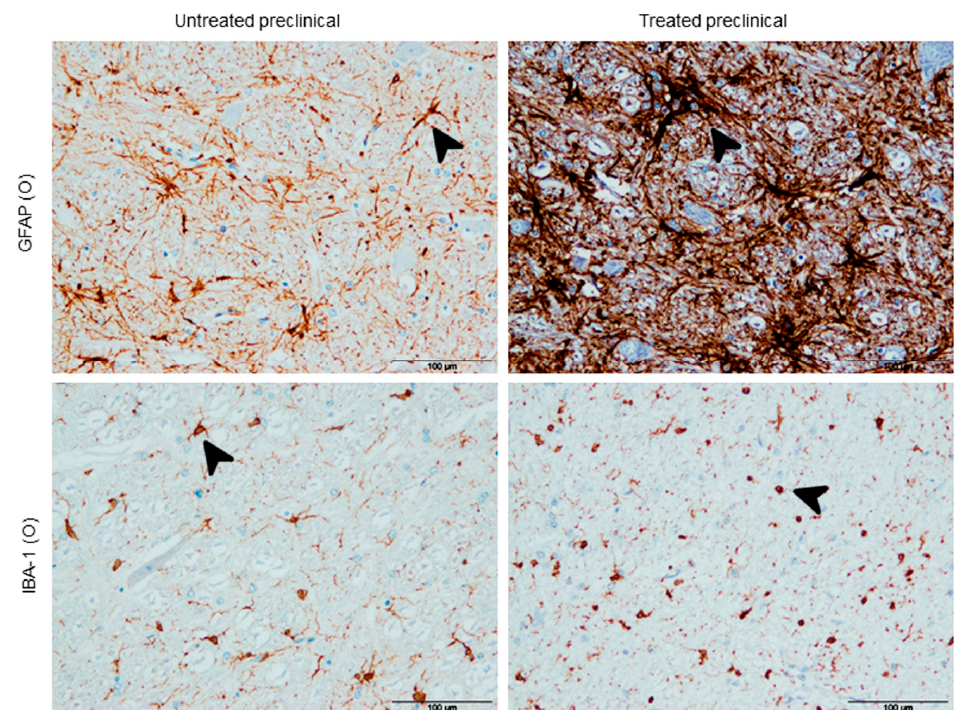
Figure 3. Morphological changes in neuroglia associated with treatment. Hypertrophic instead of stellate astroglial morphology (GFAP findings), and amoeboid instead of ramified microglial morphology (IBA-1 findings; see arrows). Scale bars: 100 µm. Obex (O).